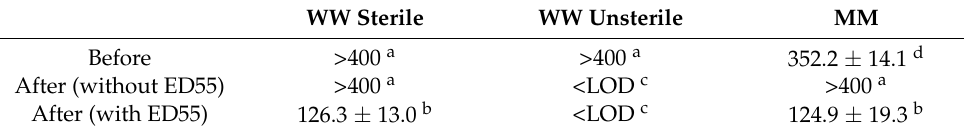
Table 4. Estrogenic activity measured using S-YES MD kit expressed in E2 equivalents (EEQ) in ng/L. WW Sterile WW Unsterile MM Before >400 a >400 a 352.2 ± 14.1 d After (without ED55) >400 a <LOD c >400 a After (with ED55) 126.3 ± 13.0 b <LOD c 124.9 ± 19.3 b Results are expressed as mean ± SD; LOD limit of detection. Means with different letters differed significantly according to Tukey’s HSD test at p <